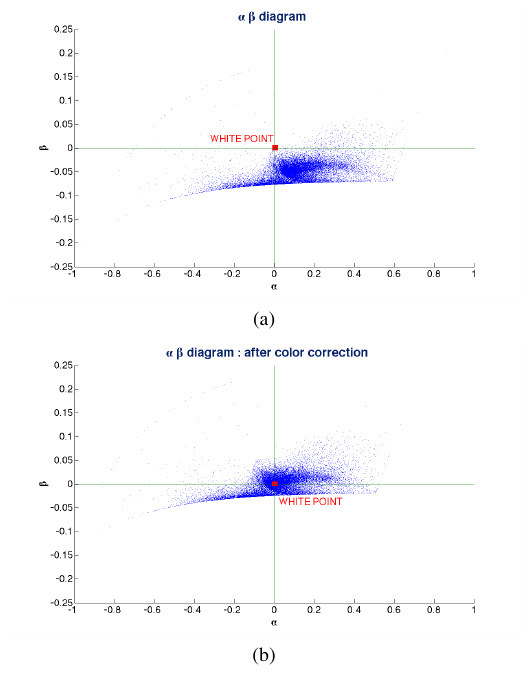
Figure 5: Distribution of chromatic components of image in Figure 4a in α − β plane before and after color